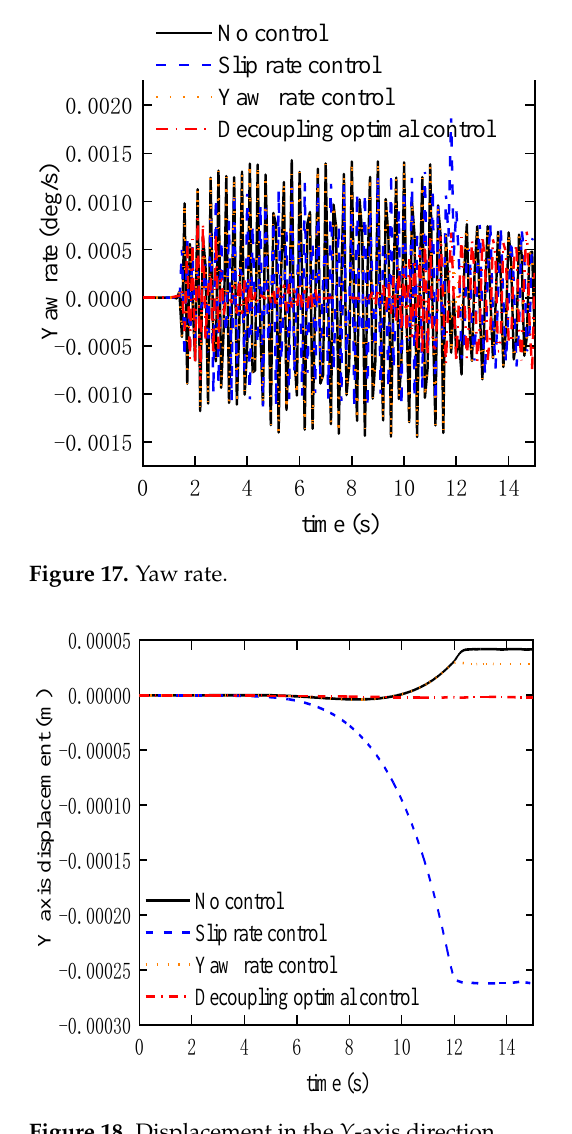
Figure 18. Displacement in the Y -axis direction.